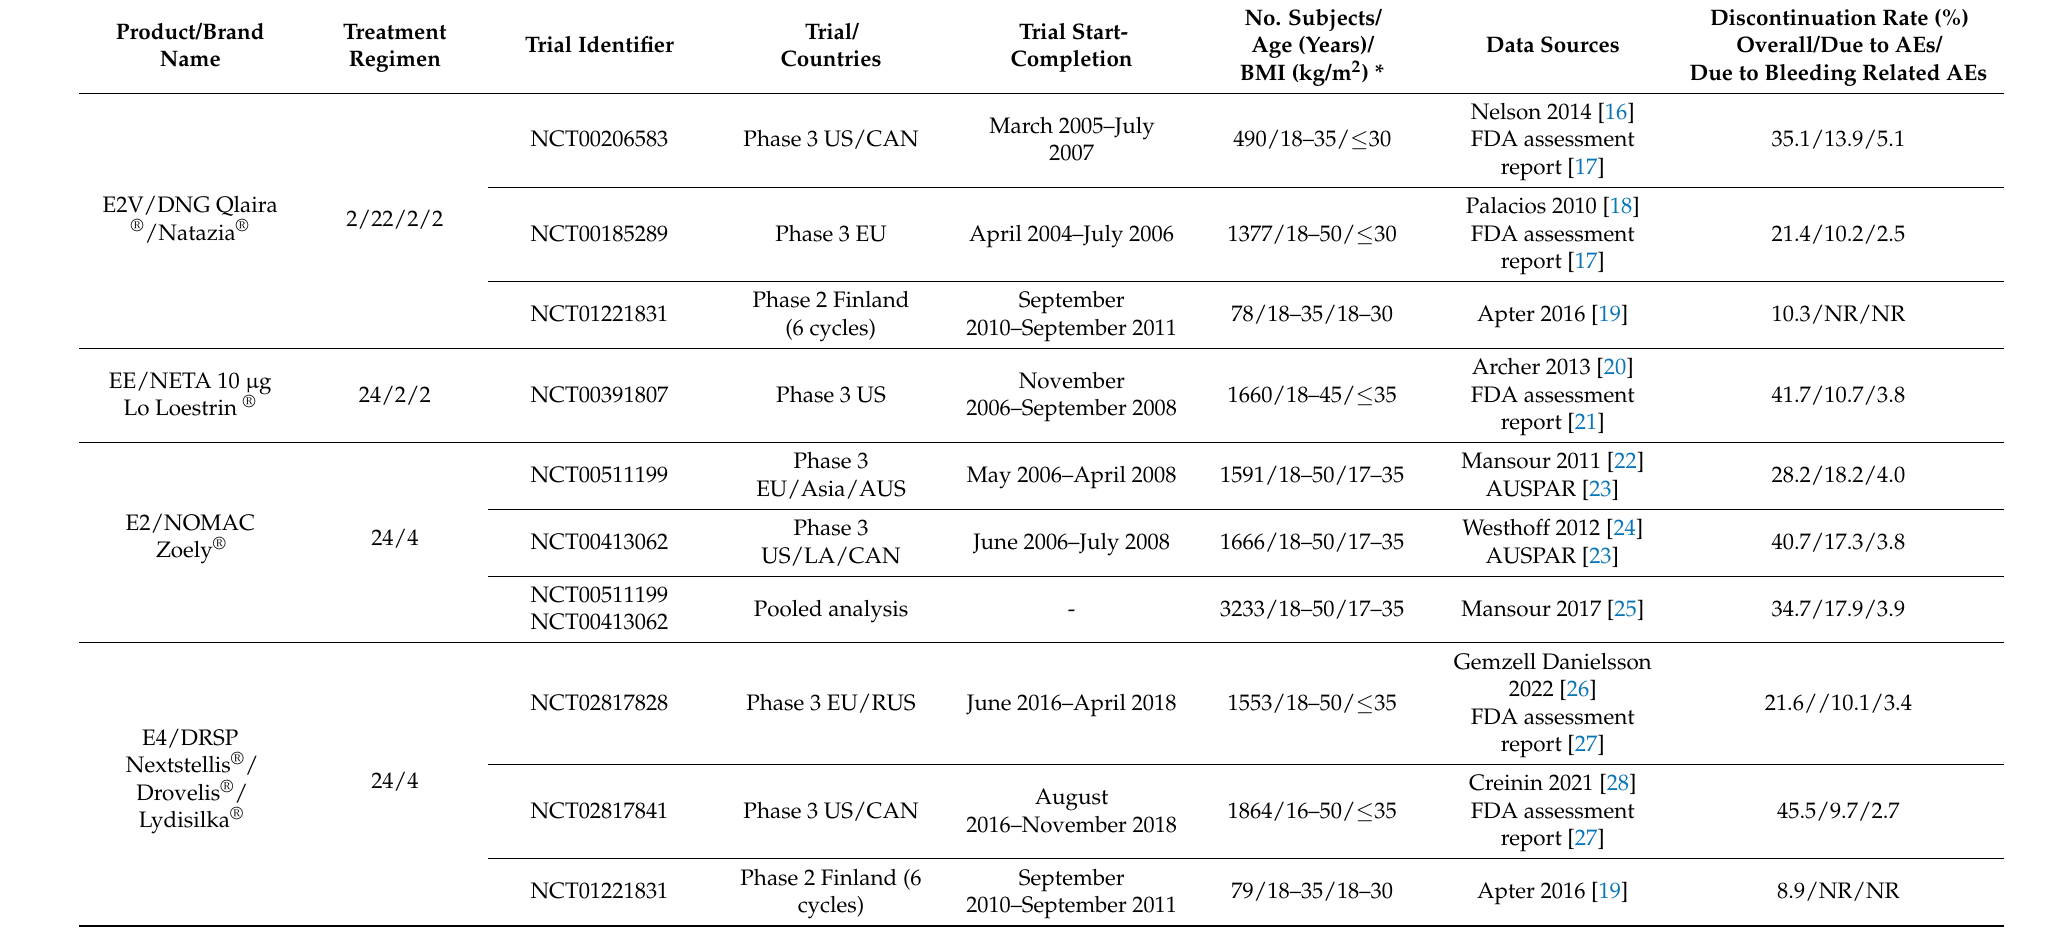
Table 2. Clinical trials and pooled analyses used for presentation of the bleeding